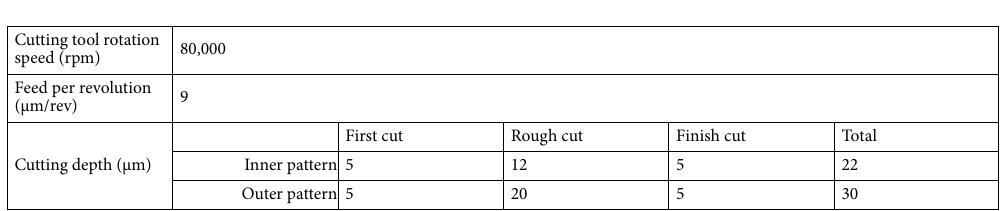
Table 1. Optimized machining conditions of the micro-end-milling process for double square array patterns on the PMMA surface.